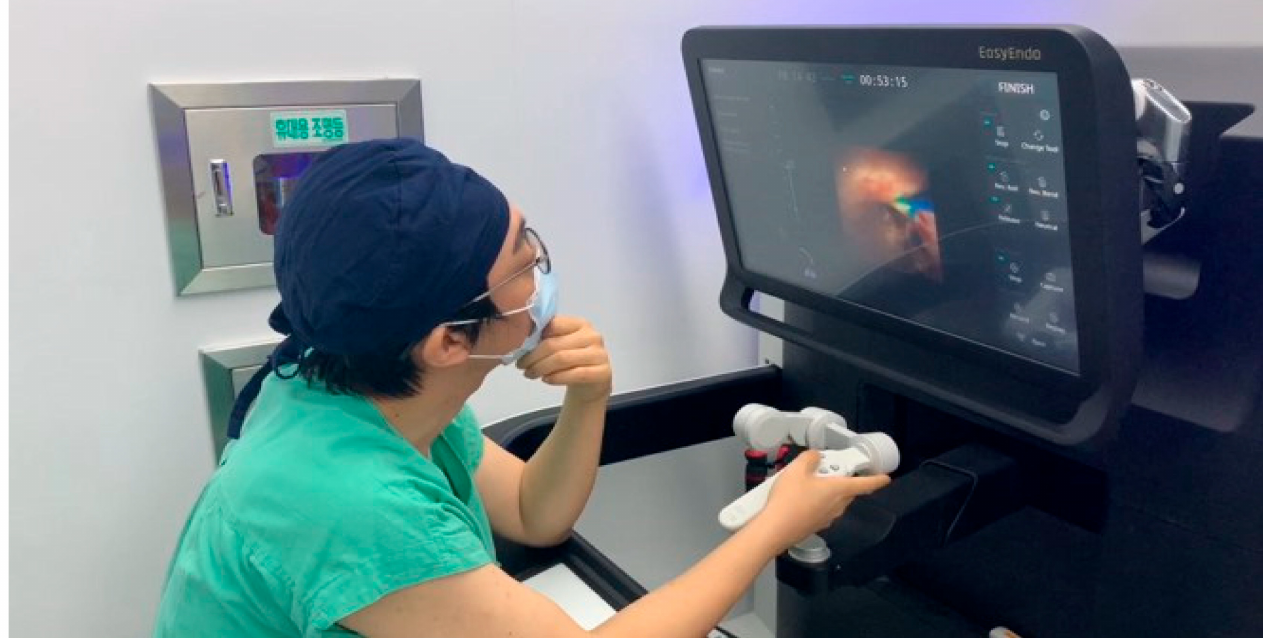
Figure 4. Easy Uretero ® robotic console navigation and basket manipulation